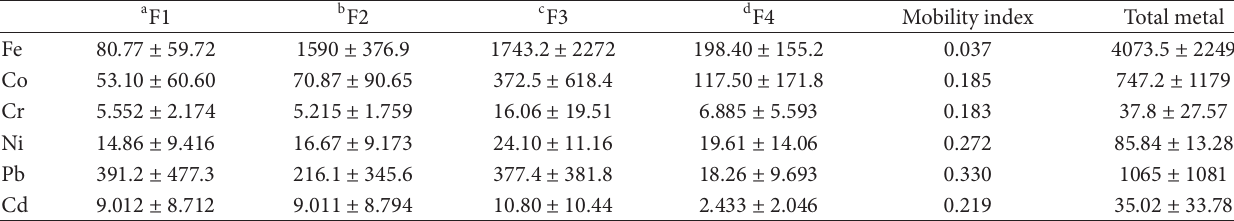
T 3: Fractionation studies of metals in soil of rice �elds,